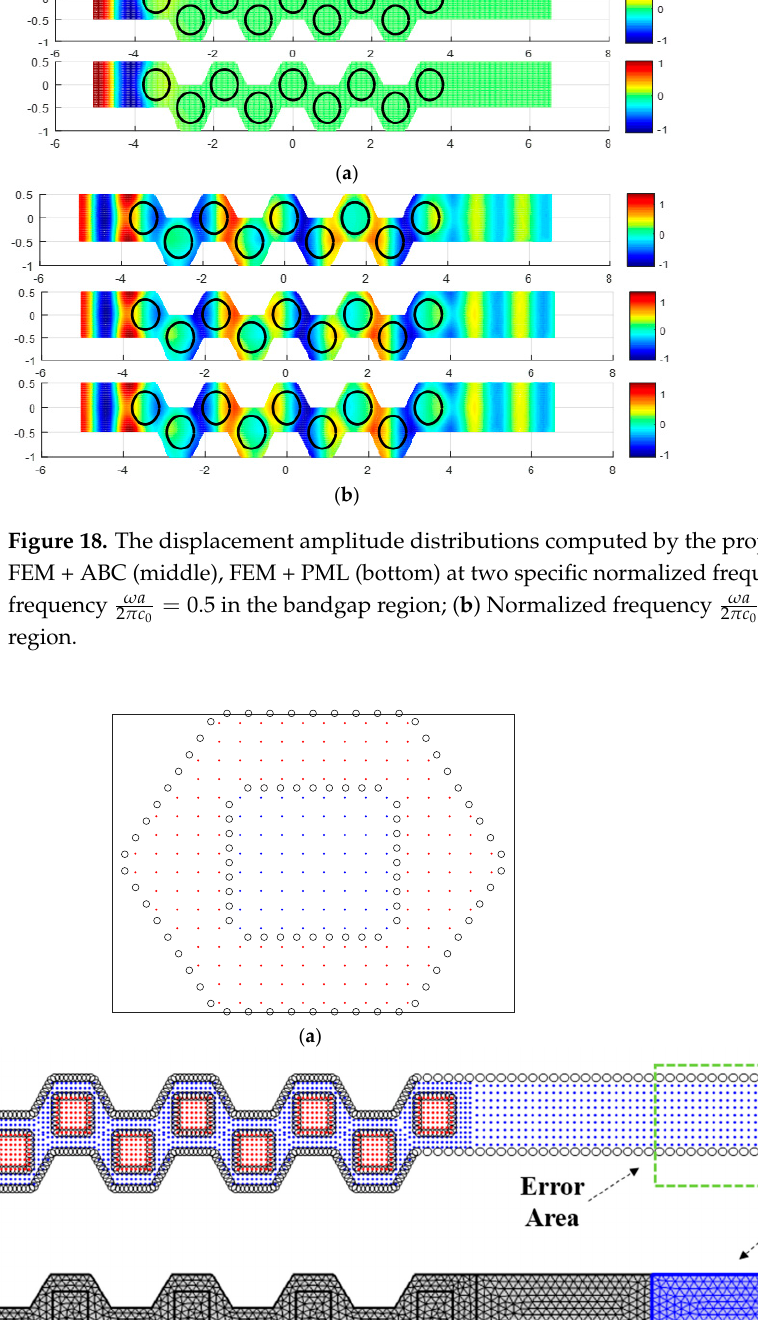
Figure 19. Nodes distribution for ( a ) the unit cell of phononic crystal with a hexagon matrix including a square scatterer; ( b ) Node distribution with error region and element distribution with PML region for the phononic crystal with semi-infinite periodic structure in the y-direction.